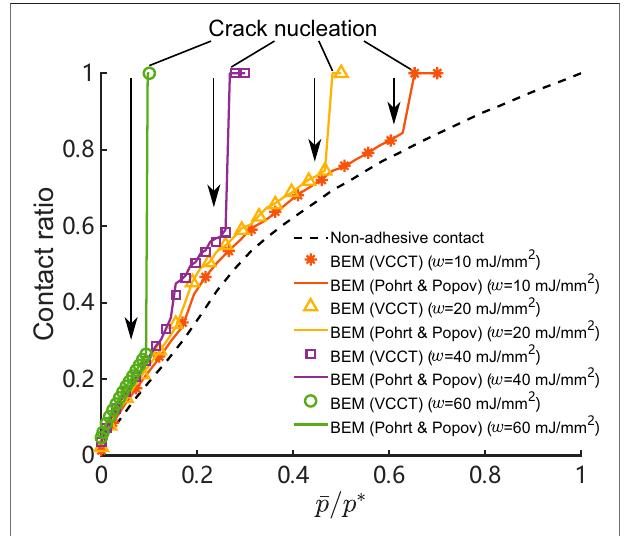
FIGURE 9 | Contact ratio to average contact pressure relation associated with multiple work of adhesion w . E * (cid:1) 1 (MPa), λ x (cid:1) λ y (cid:1) 10 (mm), Δ (cid:1) 0.1 (mm), n (cid:1) n (cid:1) 128, and w (cid:1) 0 ∼ 60 × 10 – 6 (mJ/mm 2 ). x y